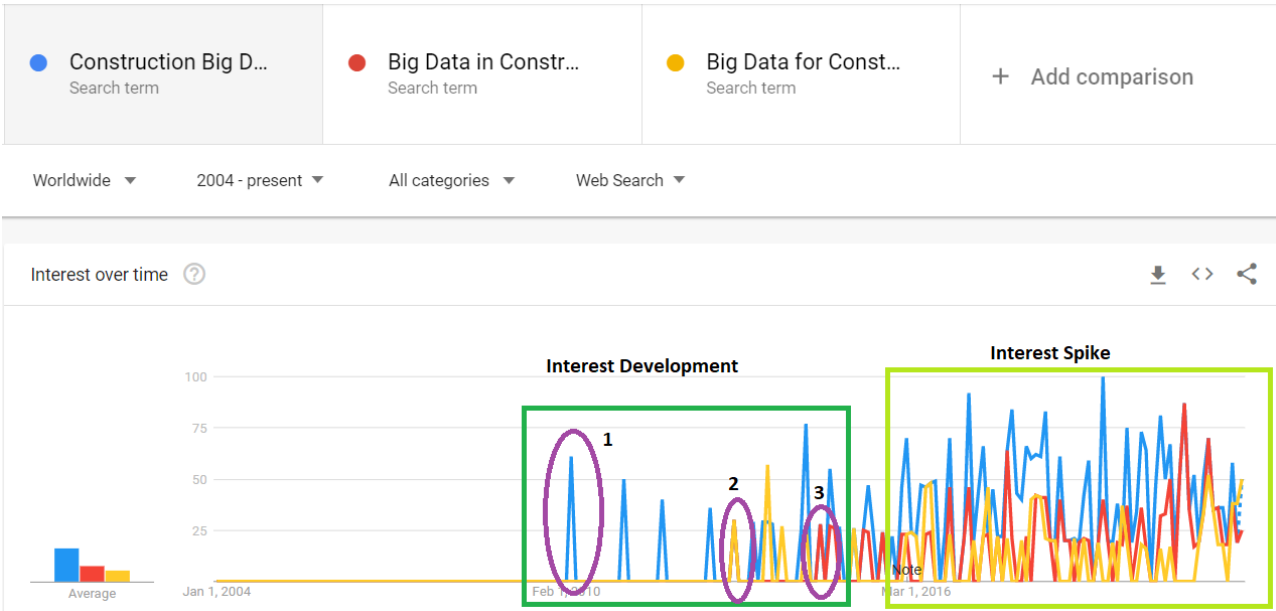
Figure 3. Google Trends analyses for big data in construction, showing interest development and spike in interest.